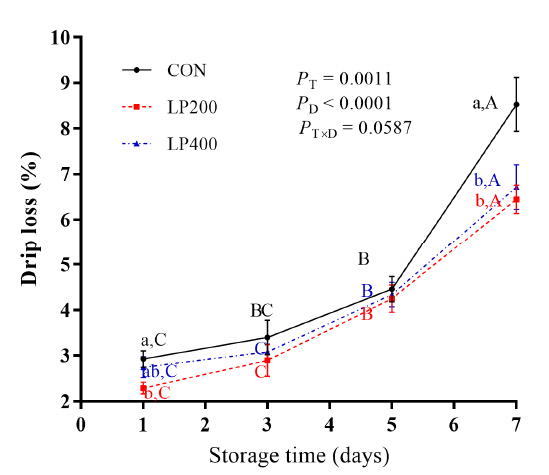
Figure 1. Effect of dietary lycopene supplementation on drip loss (on days 1, 3, 5 and 7) of longissimus thoracis (LT) muscle in lamb meat during storage ( n = 10). P T , P-value of treatments; P D , P-value of storage days; P T × D , P-value of the interaction between treatments and storage days. Different capital letters indicate significant differences ( P < 0.05) among storage time within treatment, and lowercase letters denote significant differences ( P < 0.05) among treatments within time. The error bars represent standard error. CON, control group; LP200 and LP400 mean 200 or 400 mg · kg − 1 lycopene powder supplementation in the control diet, respectively.